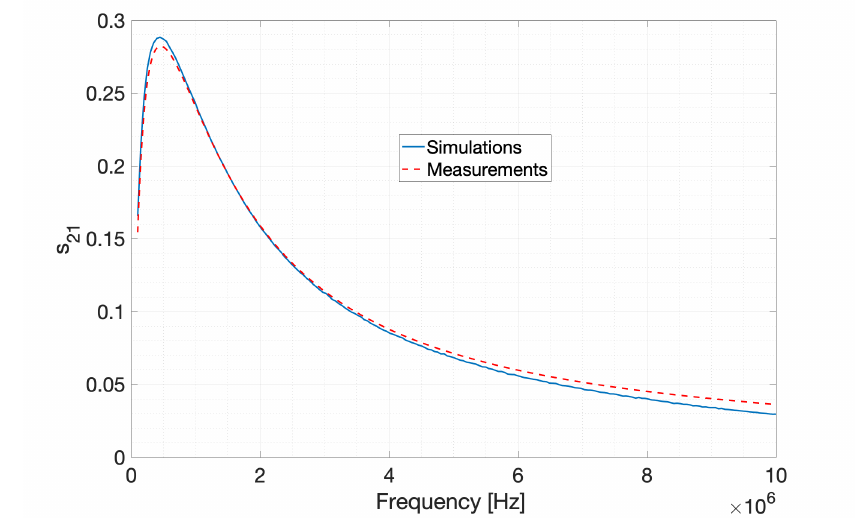
Figure 6. S 21 scattering parameter relative to the coil-loop